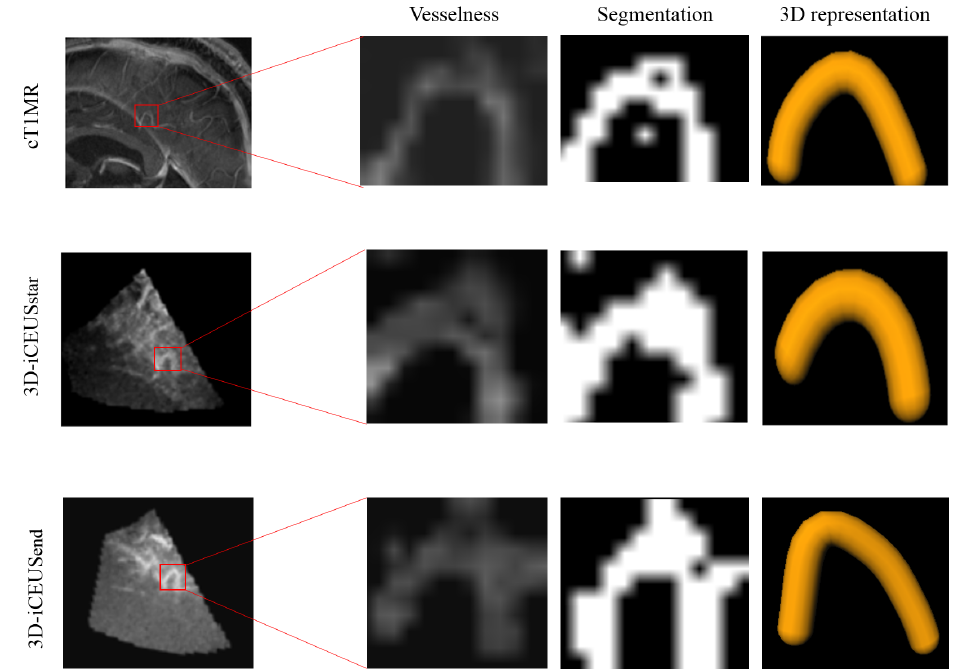
Figure 2. Illustration of vascular structure segmentation in cT1MR, 3D-iCEUS start and 3D-iCEUS end